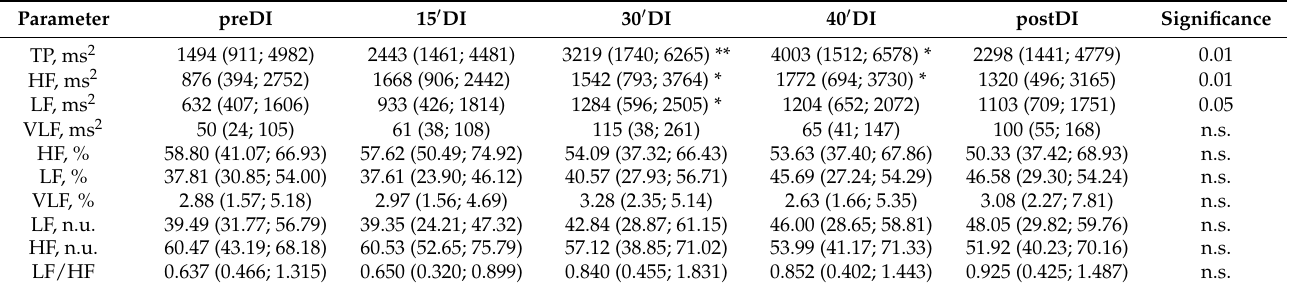
Table 2. Frequency-domain results of heart rate variability in subjects during the DI